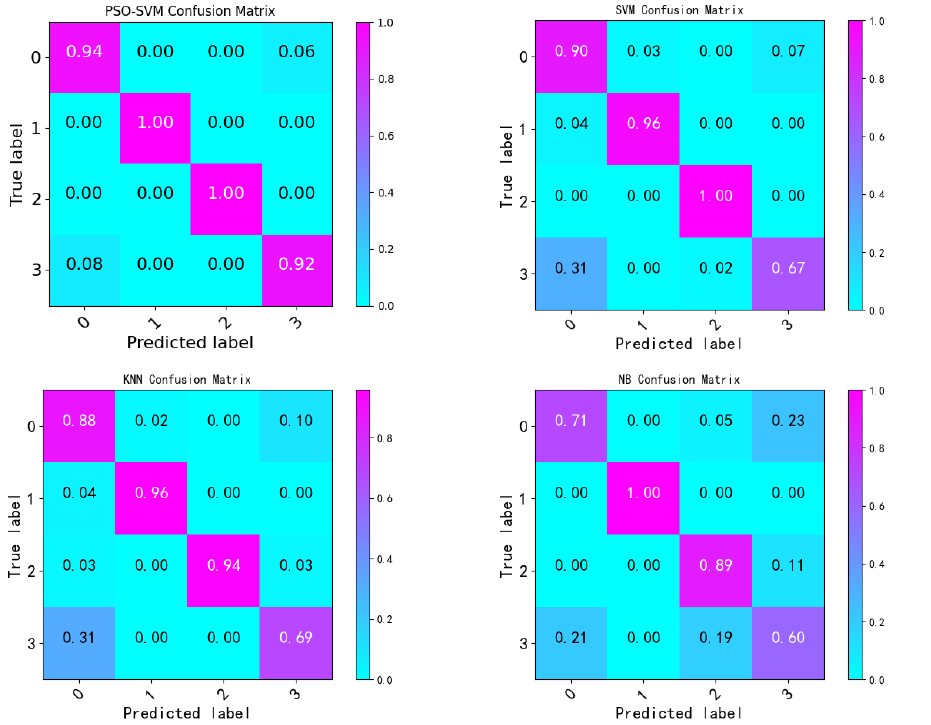
Figure 3. Comparison of the confusion matrix (scale) of the four algorithms. 0 ∼ 3 indicate the 4 labels, respectively, 0: NB-No BlOCK, 1: BlOCK, 2: No BlOCK, and 3: NB